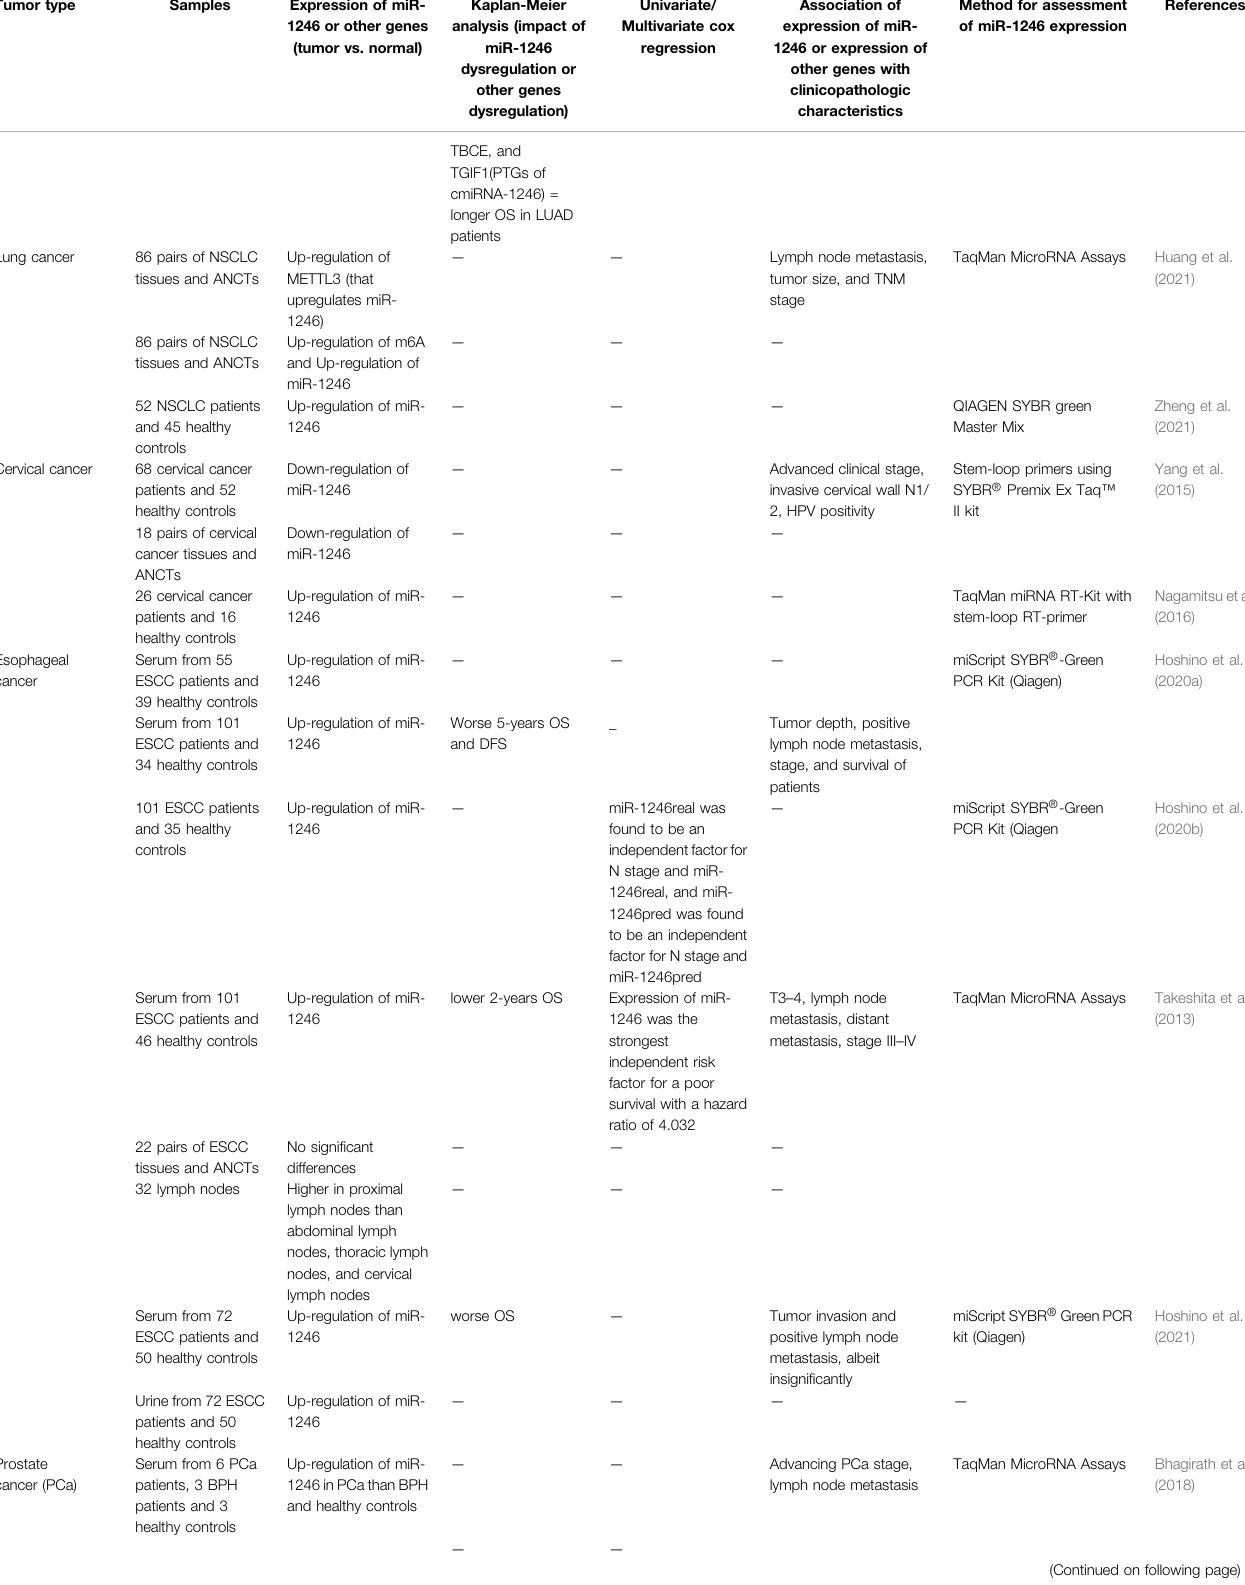
Prostate cancer (PCa)